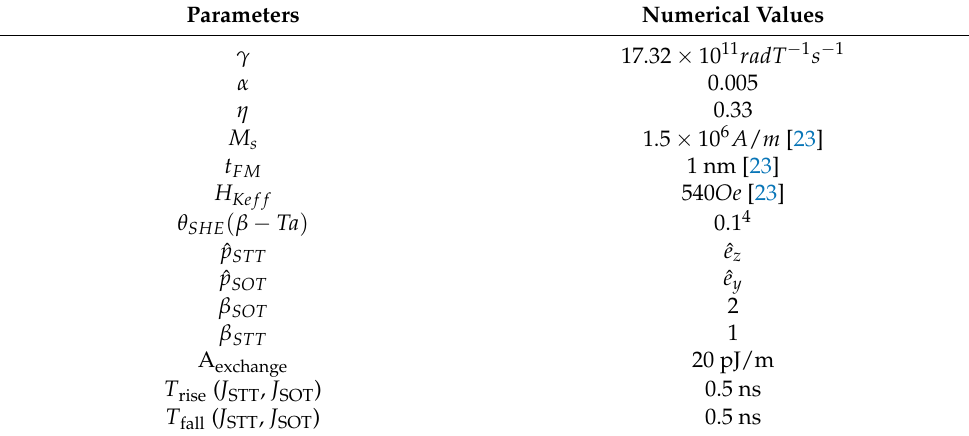
Table 1. Input parameters used in this work unless otherwise